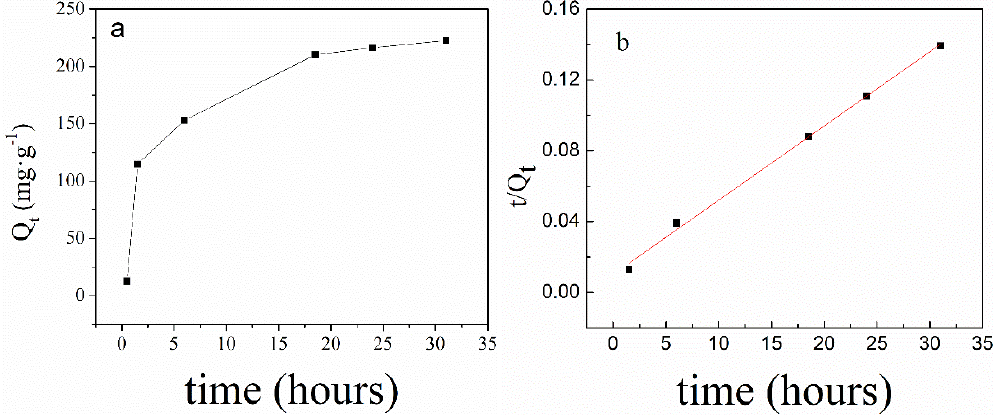
Figure 7. The amount of phosphate adsorbed by PNIPAM/SiO 2 hybrid particles in aqueous solution over time ( a ) and the adsorption kinetics of PNIPAM/SiO 2 ( b ) (pH = 7, 15 °C).